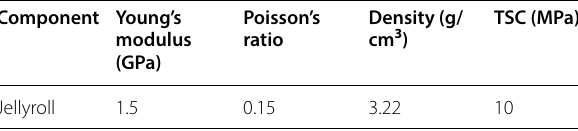
Table 7 Material parameter of jellyroll Component Young’s